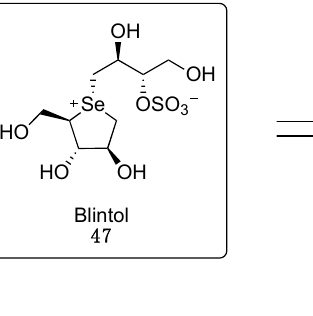
Figure 6. Structures of selenosugars 50 – 53 .